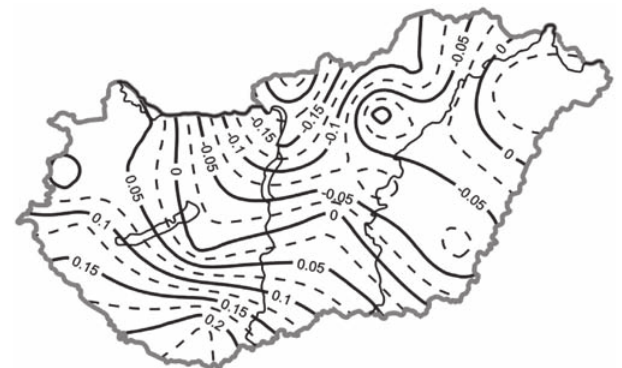
Figure 11 – The spatial distribution of mean daily slope values of the trend-function expressing the changes of the absolute daily maxima of precipitation in spring according to data raised at 16 stations over 1951–2010